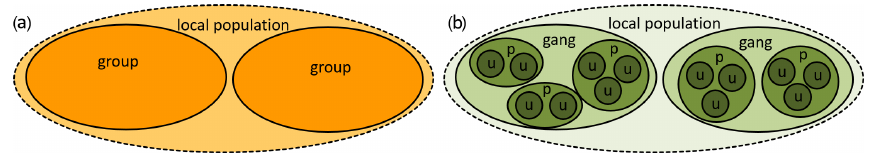
Figure 1. Sketch of the social organization of baboons. (a) Uni-level organization of COKY baboons ( Papio ursinus , P. anubis , P. kindae , and P. cynocephalus ). In these species, a group consists of several adult males and females with their offspring. Group sizes can reach more than 100 individuals. Females are predominantly philopatric and form kin-based social networks. (b) Multi-level organization of Guinea baboons ( P. papio ) and hamadryas ( P. hamadryas ). At the Centre de Recherche de Primatologie Simenti, units (u) consist of 2–10 individuals (at least one adult male and one to several adult females and their offspring), parties (p) of 30.5 ( ± 6 . 4), and gangs of more than 60 individuals. The size of our study population at Simenti is 350–400 individuals ( > 7 . 5 individuals per square kilometre) and is most likely equivalent to a local population. In hamadryas baboons, corresponding levels of the social organization are one-male unit (OMU), clan, band, and troop (Kummer,